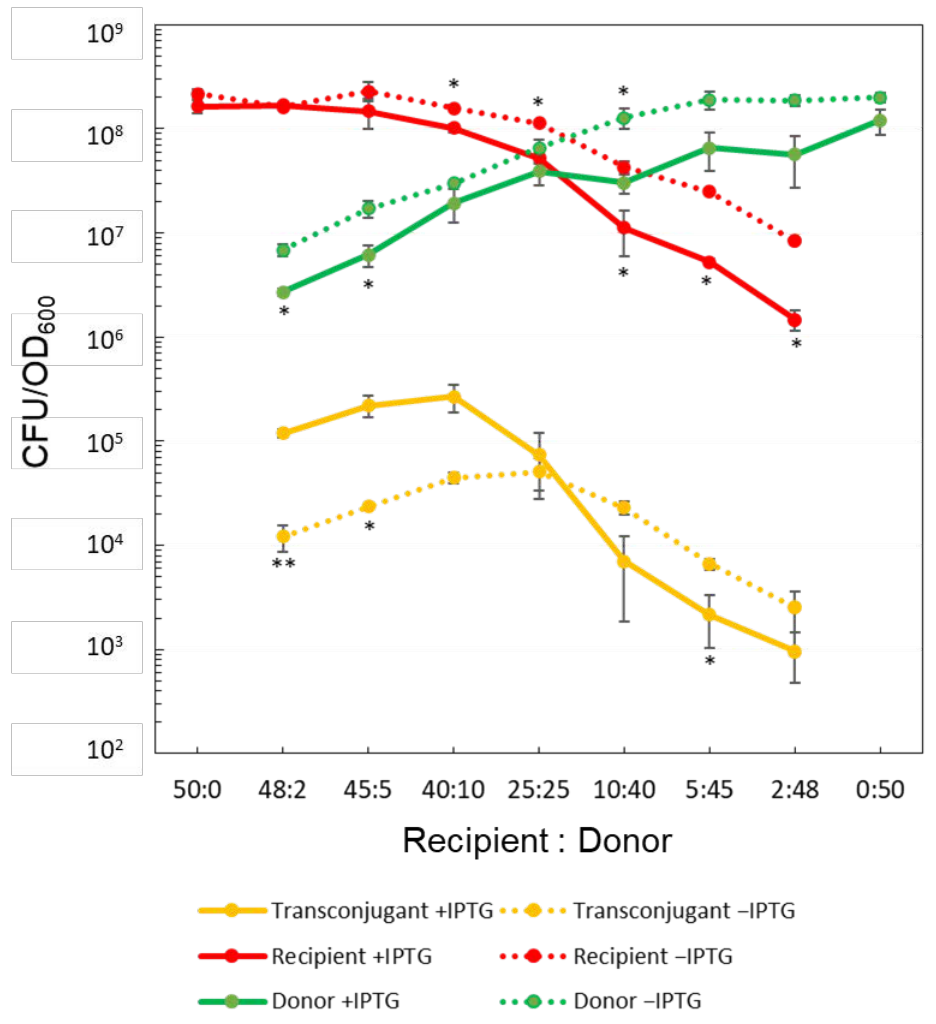
Figure 1. Summary of colony formation assays. Strains KV7 and KV9 were grown to OD 600 = 0.5 (+/ − IPTG only for KV9), mixed in various ratios for conjugation, and spread on agar plates to form colonies to calculate the respective CFU/OD 600 under the appropriate selective conditions; both cat and erm for donors, tet for recipients, and both erm and tet for transconjugants. The values are the means ± SD of three independent experiments with similar results. Statistical significances by t -test due to the presence of IPTG are indicated (* p < 0.05; ** p <